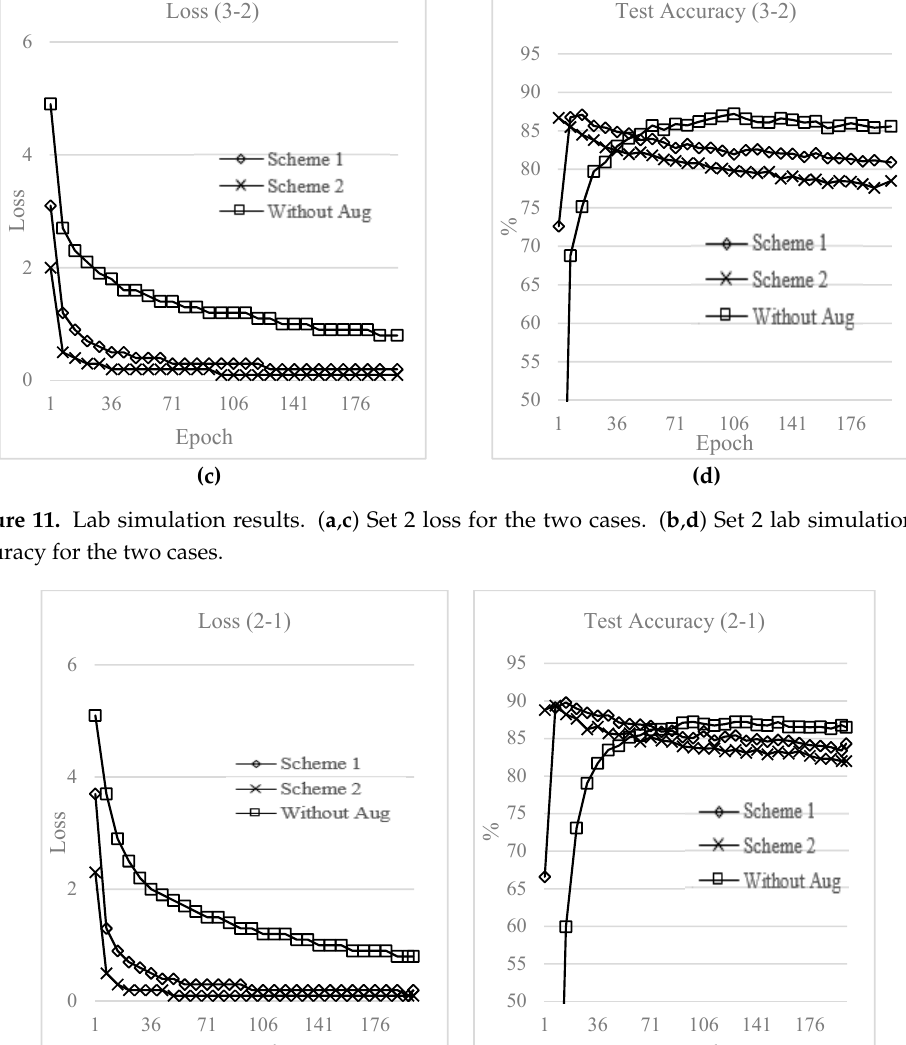
Figure 12. Lab simulation results. ( a ) Set 3 loss and ( b ) Set 3 lab simulation test accuracy.